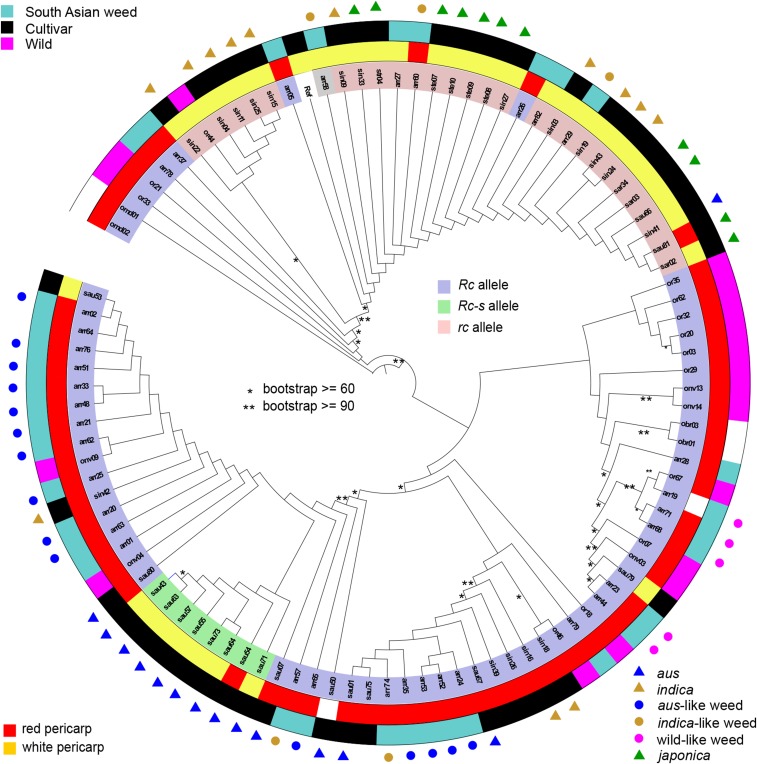
Neighbor joining (NJ) tree of Rc haplotypes. The color range indicates the three major alleles of the Rc gene; the inner ring indicates the colors of the pericarp. The outer ring and the bullets indicate Oryza groups, as labeled in the key. Unmarked weeds are admixed according to results of Huang et al. (2017). Asterisks on branches indicate bootstrap values as labeled.